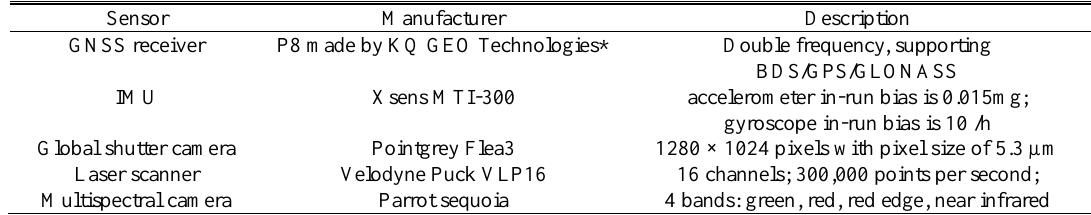
Table 1. Sensors specifications.